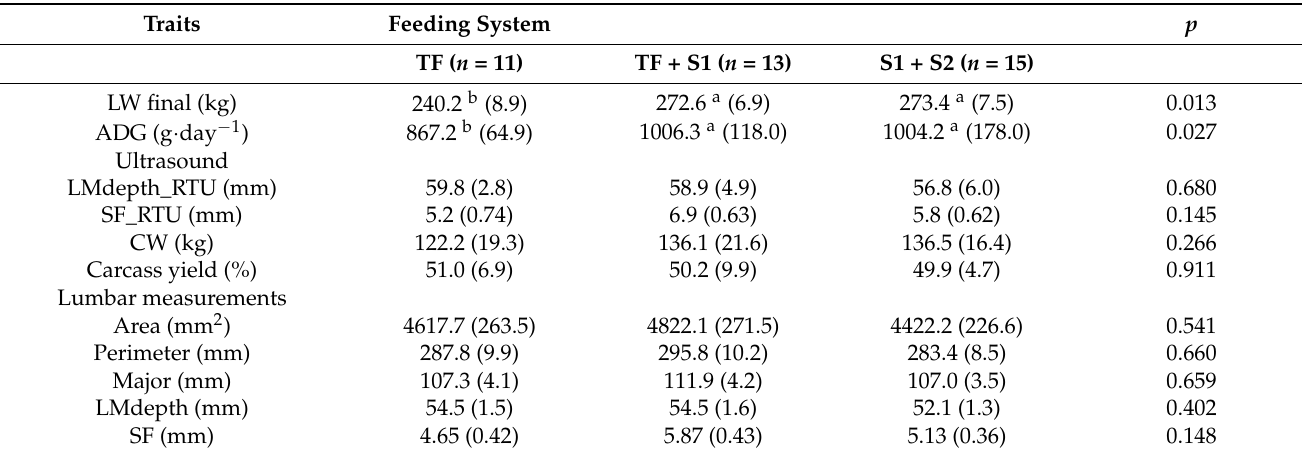
Table 2. Least square means and standard errors (in parenthesis) for live weight, ADG, ultrasound measurements, carcass weight, carcass yield, and lumbar measurements for steers from TF, T + S1, and S1 + S2 feeding systems (Experiment 1).